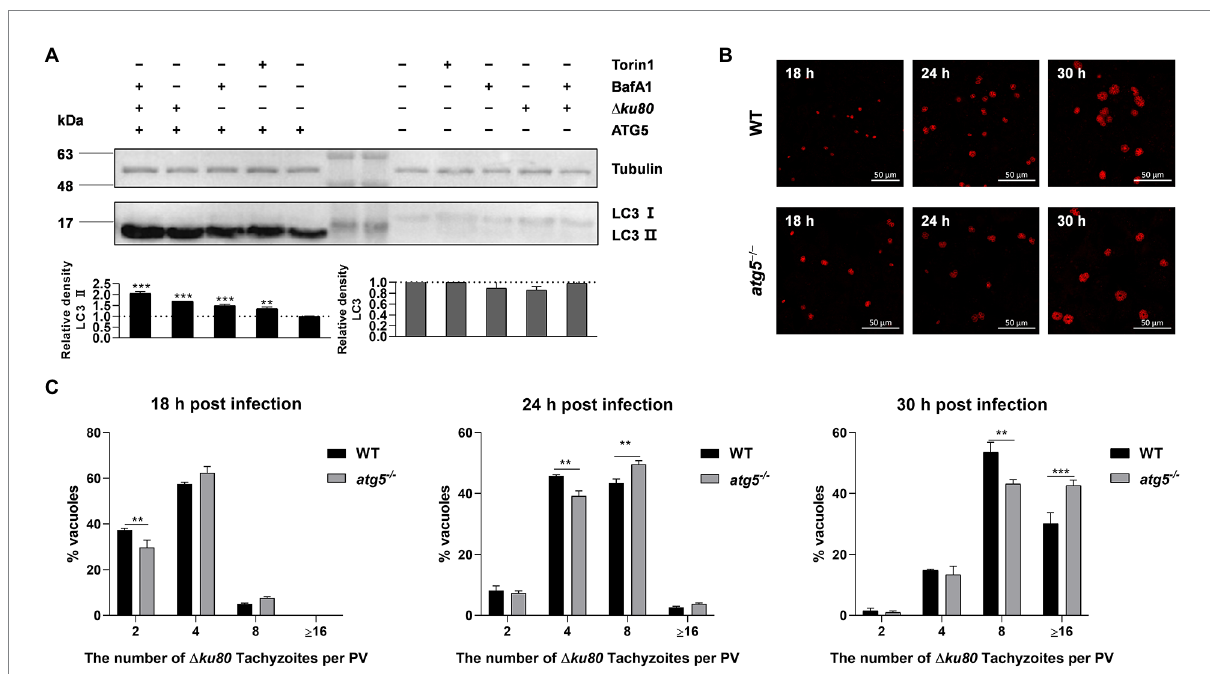
FIGURE 5 Disruption of ATG5 enhances T. gondii proliferation in vitro . (A) Wild-type and atg5 − / − HeLa cells were harvested and prepared at 24 h post- infection. Proteins of equal amounts of cell lysates were separated on 15% SDS-PAGE gels. LC3 (16 ~ 18 kDa) was detected using rabbit anti-LC3 monoclonal antibody, and Tubulin (~55 kDa) expression was detected using mouse anti- β -tubulin polyclonal antibodies as a loading control. Relative densities of whole LC3 or LC3 II were the ratios of the density of whole LC3 or LC3 II to the density of Tubulin. The relative densities of the negative controls were set as one arbitrary unit whereas those of the treated groups were ratios to the negative controls. Each value was the mean ± SEM of three measurements (** p ≤ 0.01; *** p ≤ 0.001; t -tests) (B) Wild-type and atg5 − / − HeLa cells were challenged by T. gondii RH ∆ ku80 tachyzoites at an MOI of 2:1, and fixed with methanol at 18, 24 and 30 h post-infection. Rabbit anti-TgGAP45 antibodies were used to label the parasite tachyzoites. (C) Replication of parasites was determined by the proportion of vacuoles containing 2, 4, 8, and 16 or more tachyzoites. Each value is the mean ± SEM of three counts (** p ≤ 0.01; *** p ≤ 0.001; two-way